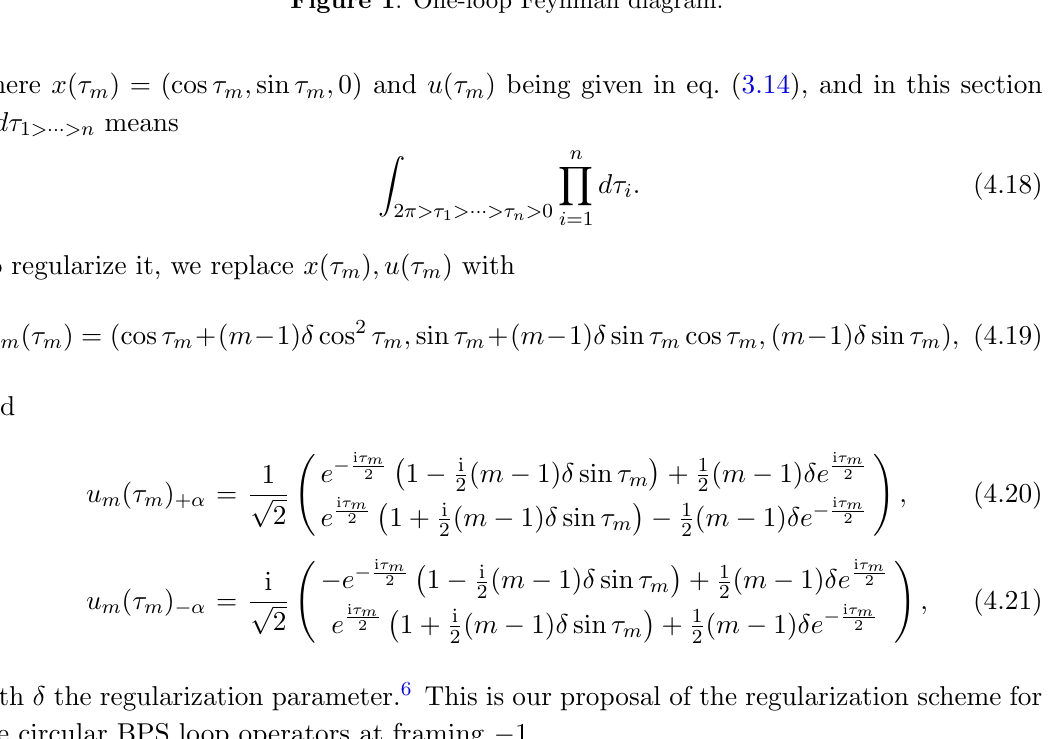
Figure 1 . One-loop Feynman